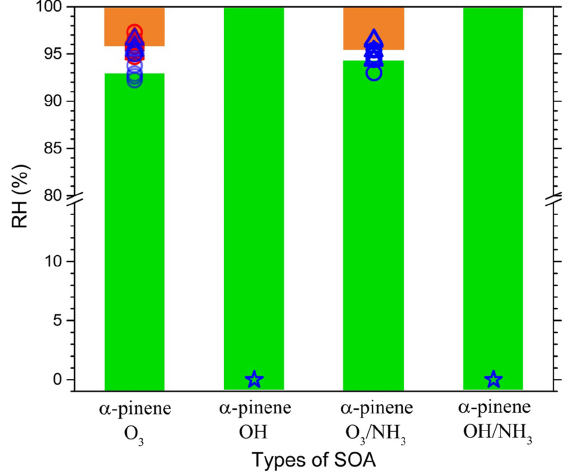
Figure 5. Relative humidity (RH) at which the two phases were ob- served during RH scanning as a function of the four different types of SOA particles. Blue and red symbols are from this study and from Renbaum-Wolff et al. (2016), respectively. Circles represent the merging RH (MRH) for RH decreasing, and triangles represent the separation RH (SRH) for RH increasing. A RH of 0% indicates no LLPS. The green shaded region indicates one phase present, and the orange shaded region indicates two phases present in the SOA particles.